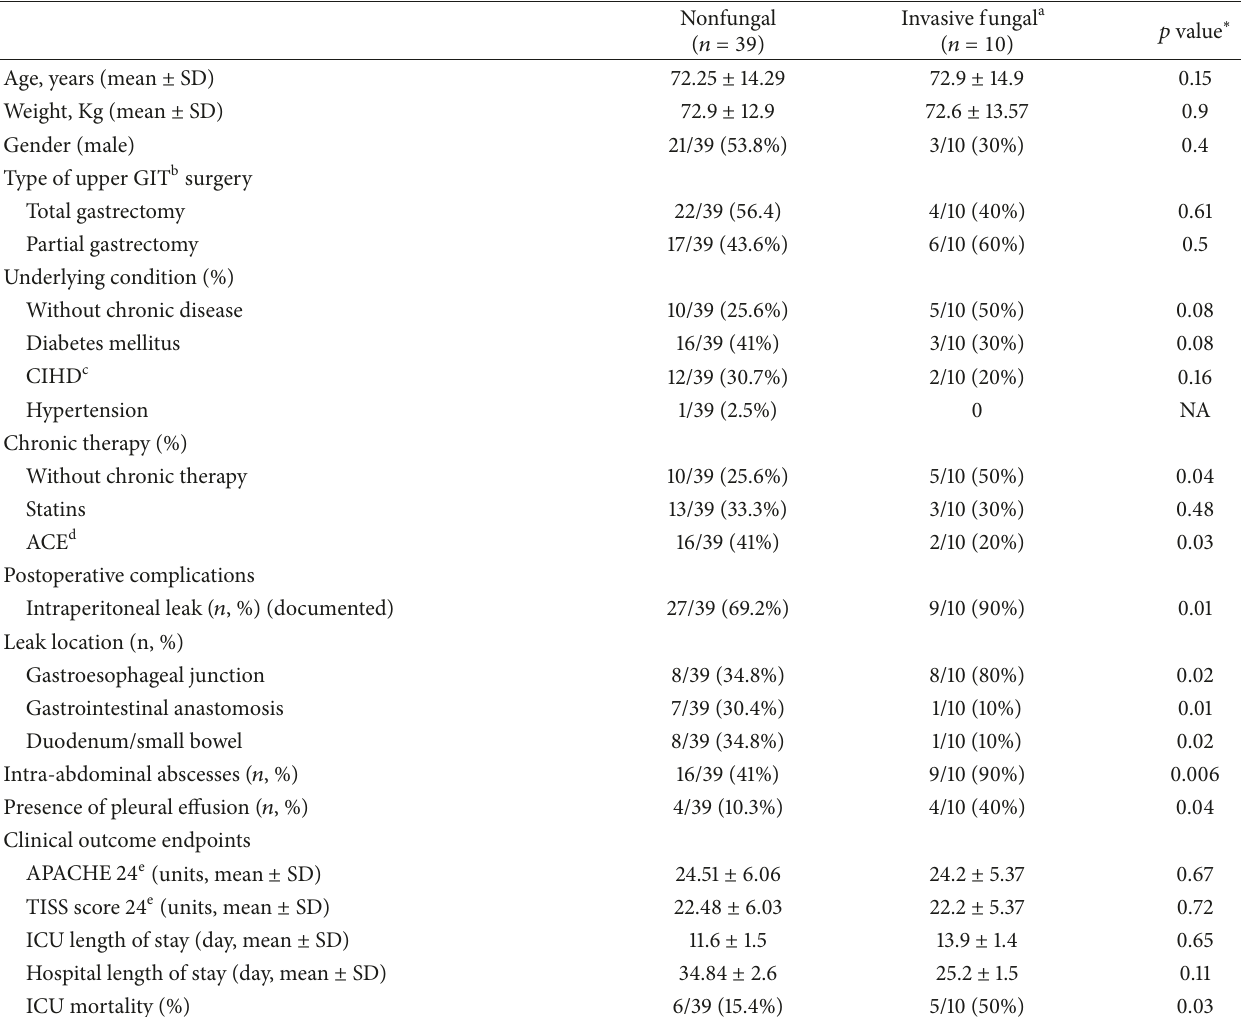
Table 2: Demographic data, postoperative infectious complications, and clinical outcomes endpoints of Group 2 patients divided into nonfungal and invasive fungal subgroups ( 𝑛 , %, mean ±